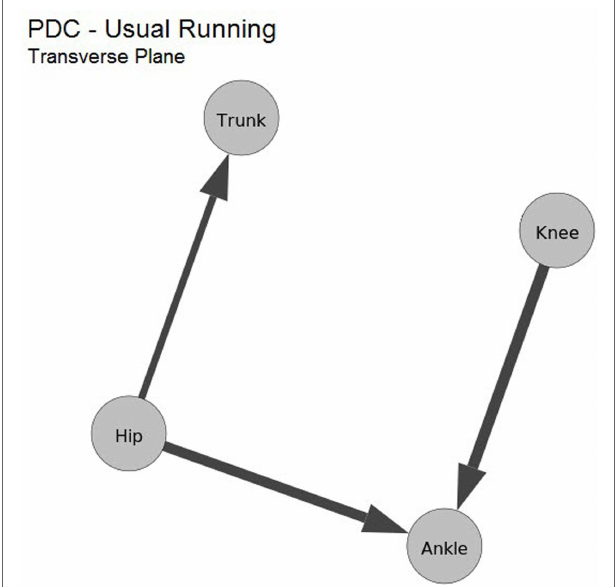
FIGURE 6 | Average values computed from maximum PDC values of the frontal plane kinematic data during running. Also, nodes are the kinematic data. TABLE 3 | Average values (SD) computed from causal influence in the transverse plane kinematic data during running. Pair Distal–prox Proximal–distal t-test Permutation